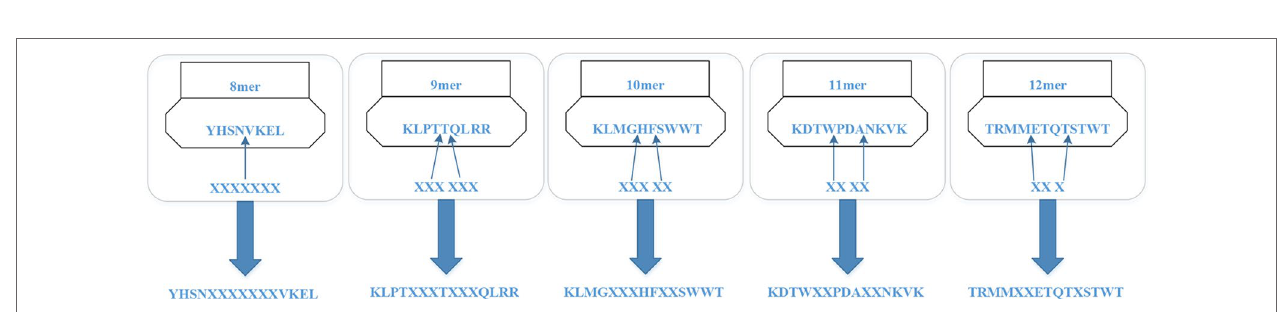
FIgURe 2 | Encoding peptides of different